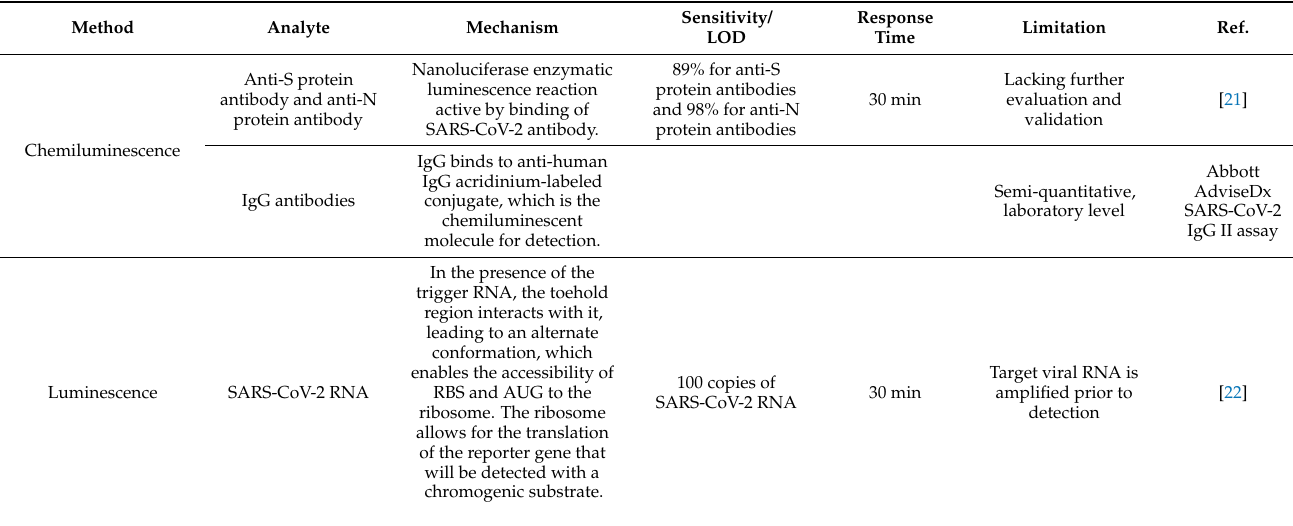
Table 2. Photonic biosensors for COVID-19